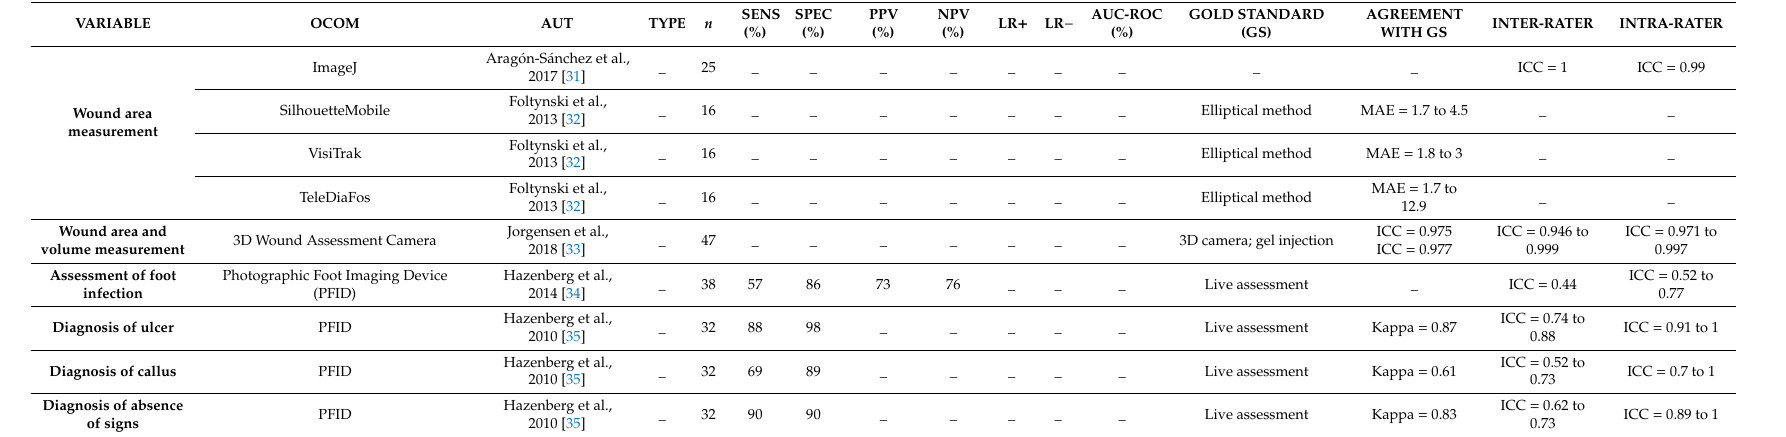
Table 3. Variables related to ulcer characteristics and the OCOMs validated for their assessment; sensitivity (SENS).